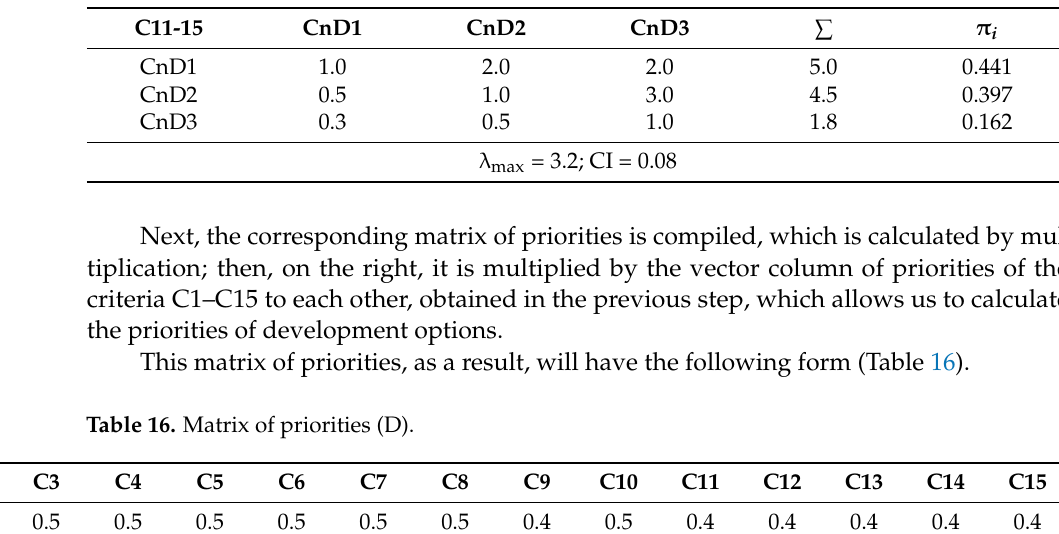
Table 15. Matrix of judgments.